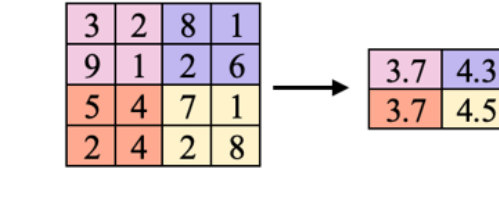
Figure 10. Model 1- sequential model’s layers. 4.3.2. Using Pre-Trained Models Another approach in image classification is fine-tuning pre-trained models, also known as transfer learning. The concept of transfer learning is that instead of starting from scratch, models have been previously trained on various images. Those skills are then transferred over to when the model is training and evaluating new data sets. Moreover, they have been designed with specific architectures and pre-defined weights; weights are a value that represents how the connection between each node in a layer facilitate transfer learning. Models from scratch are associated with high computational cost, acting as the driving factor to use these specific pre-trained models. They also require large amounts of data to effectively learn features and then generalise them to make accurate predictions. However, this is not always possible, as in many cases, the available data is limited, which is an issue we encountered. Therefore, we used pre-trained models in this binary classifi- cation study which were Inception-V3, ResNet-50, and VGG16 (Figure 11). These models were previously trained on large sets of data and were later fine-tuned on the confocal images. The same optimization configuration (optimizer = Adam and lr = 0.001) was used for all models. This configuration was tuned for best performance with Inception V3 be- cause of its less computational power and we did not attempt to tune optimization hy- perparameters for individual models separately.